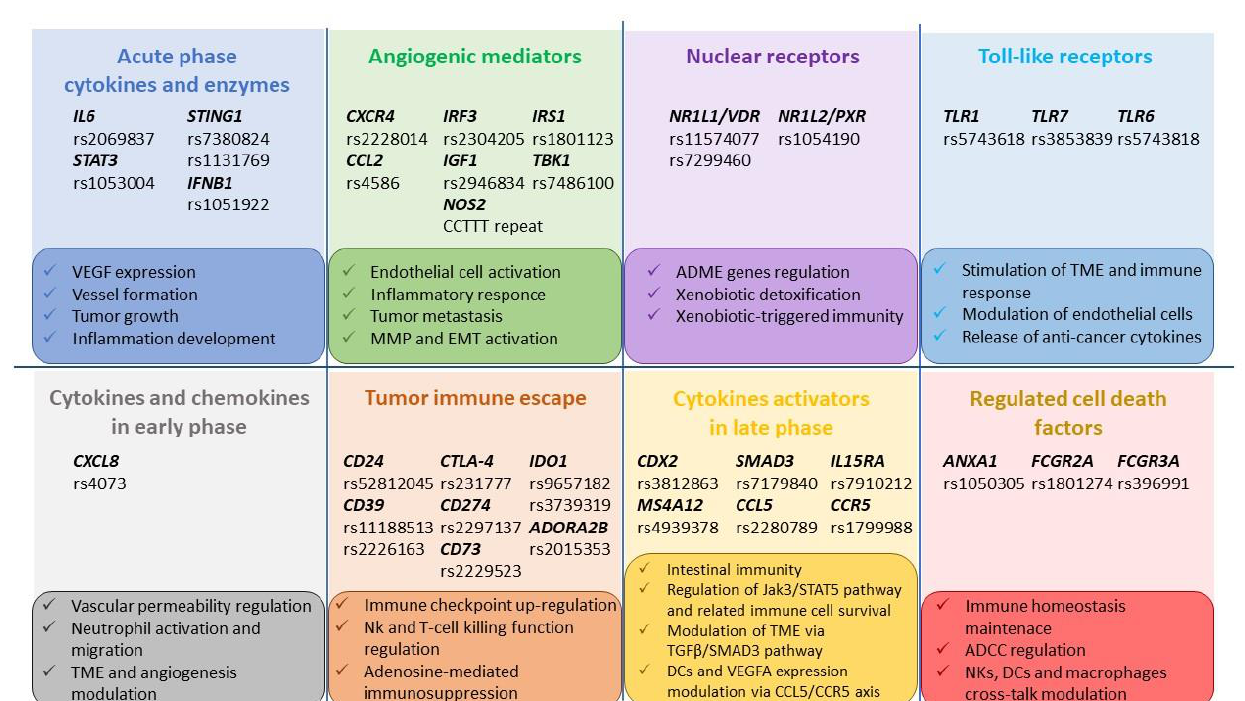
Figure 3. Promising genes and related pathways influenced by polymorphisms. Abbreviations : VEGF: Vascular Endothelial Growth Factor; MMP: Matrix metalloproteinases; EMT: Epithelial- mesenchymal transition; ADME: absorption, distribution, metabolism, and excretion; TME: tumor microenvironment; Nk: Natural Killer; DCs: Dendritic